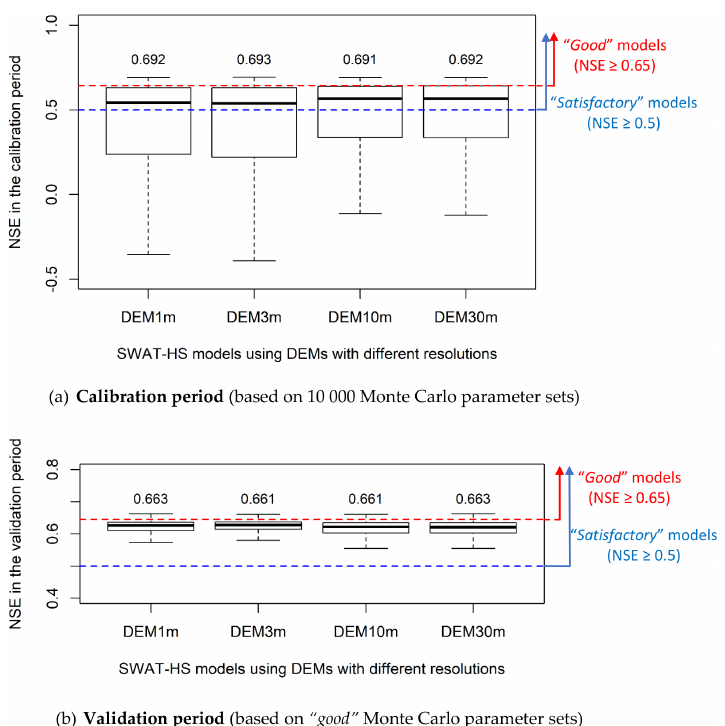
Figure 5. Box plots of NSE values in SWAT-HS setups with different DEM resolutions for calibration and validation periods (the number above the box plot is the maximum NSE of each